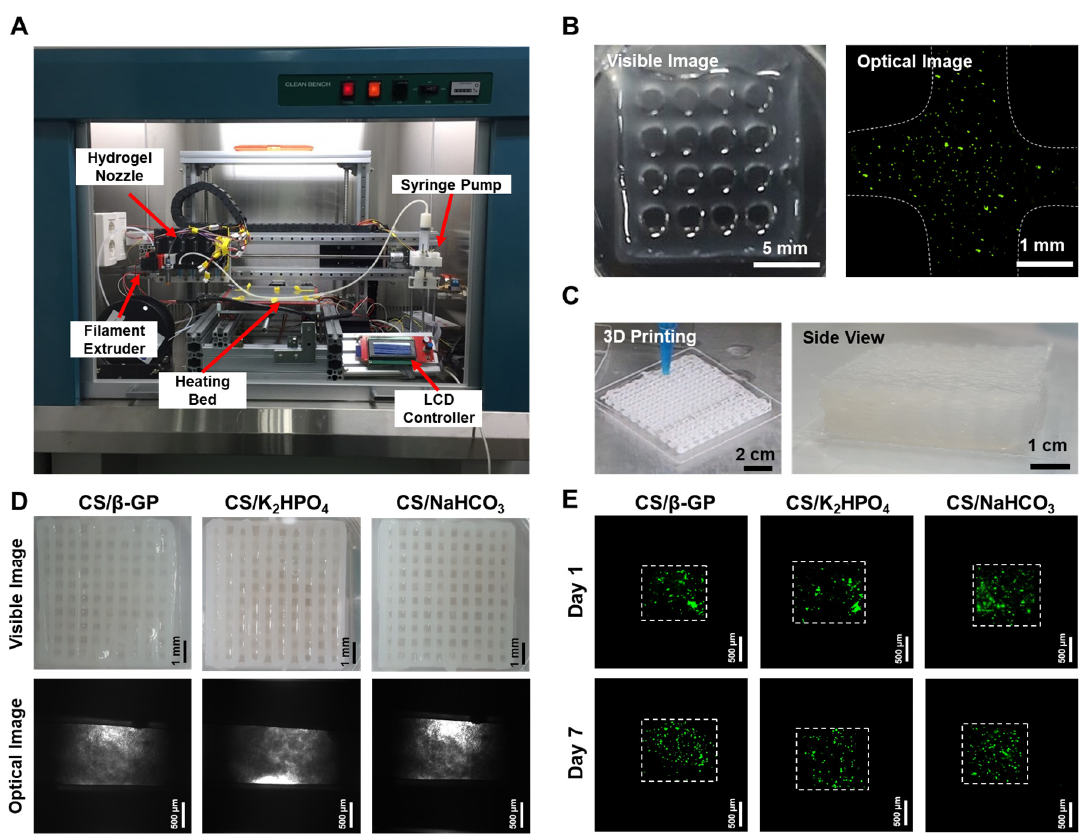
Figure 3. 3D printability of CBIs. ( A ) The 3D bioprinting system used in this study. ( B ) 3D bioprinting of cell-laden CBIs. ( C ) 3D bioprinting processes for the PCL and CBI constructs. ( D ) Representative microscopy images of 3D bioprinted structures using PCL and PDLSC-encapsulated CBIs. ( E ) Live and dead cell assay of 3D bioprinted cells (green: live cells; red: dead